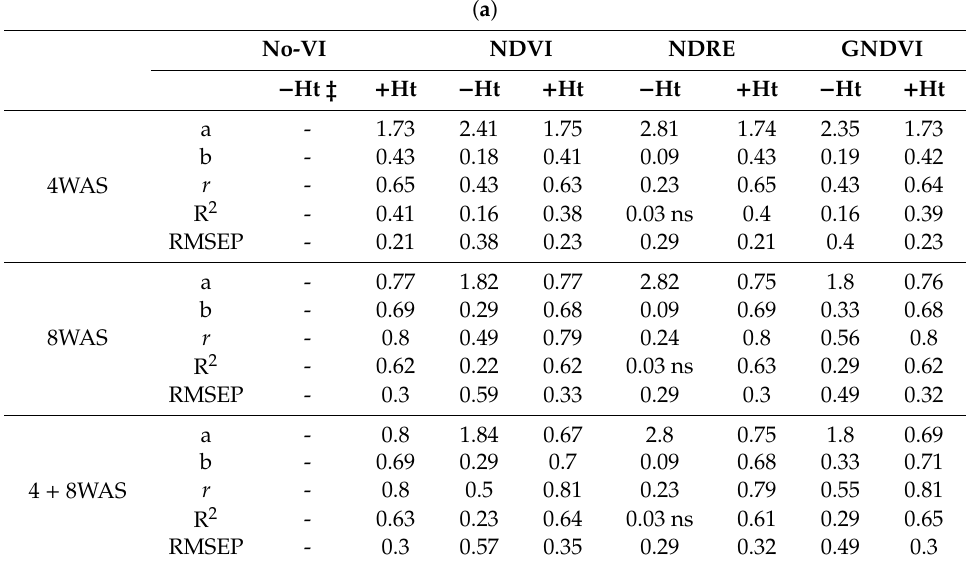
Table 3. ( a ): Model performance metrics for maize grain yield prediction using UAV-derived vegetation indices (VI) with (out) inclusion of the measured biophysical variable, height (Ht) in multilocational nutrient omission trials (NOTs) near to farmers’ fields. ( b ): Model performance metrics for maize grain yield prediction using UAV-derived vegetation indices (VI), with(out) inclusion of the measured biophysical variable, height (Ht) in multilocational smallholder farmers’